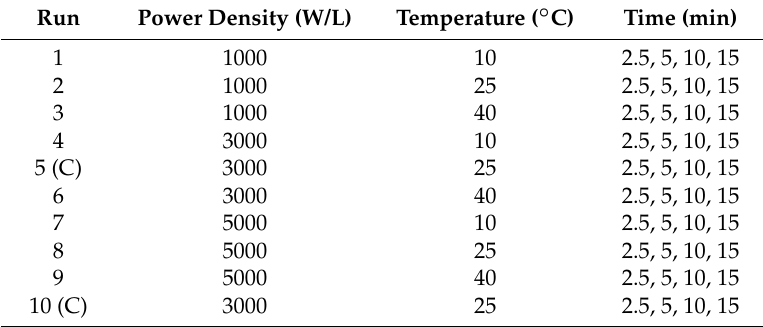
Table 1. Experimental design applied in the study on the effects of sonication in acerola juice.